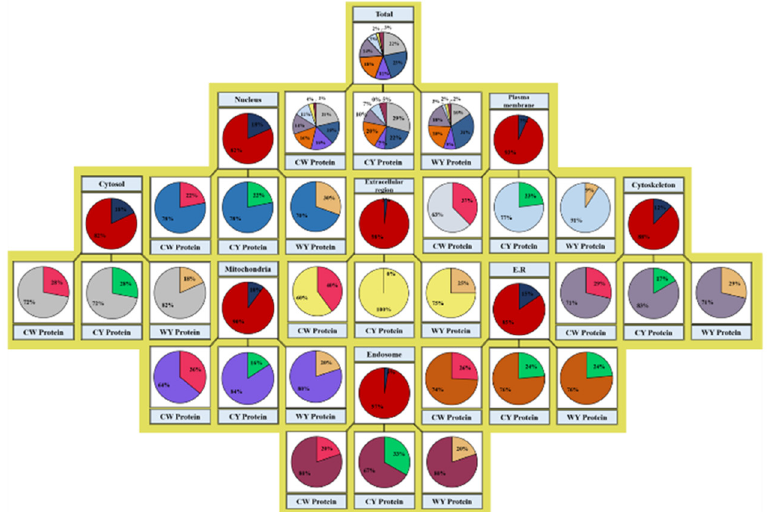
Figure 5. Classification of differentially expressed protein based on subcellular localization of identified proteins.